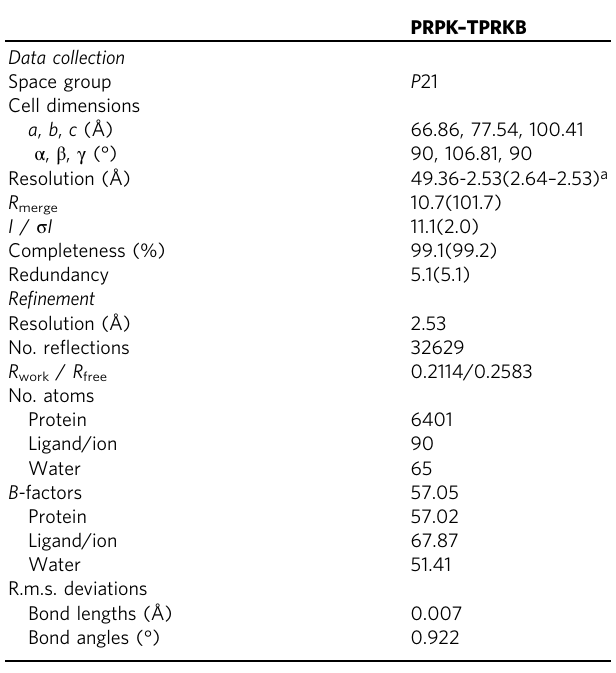
Table 3 Data collection and re fi nement statistics (molecular